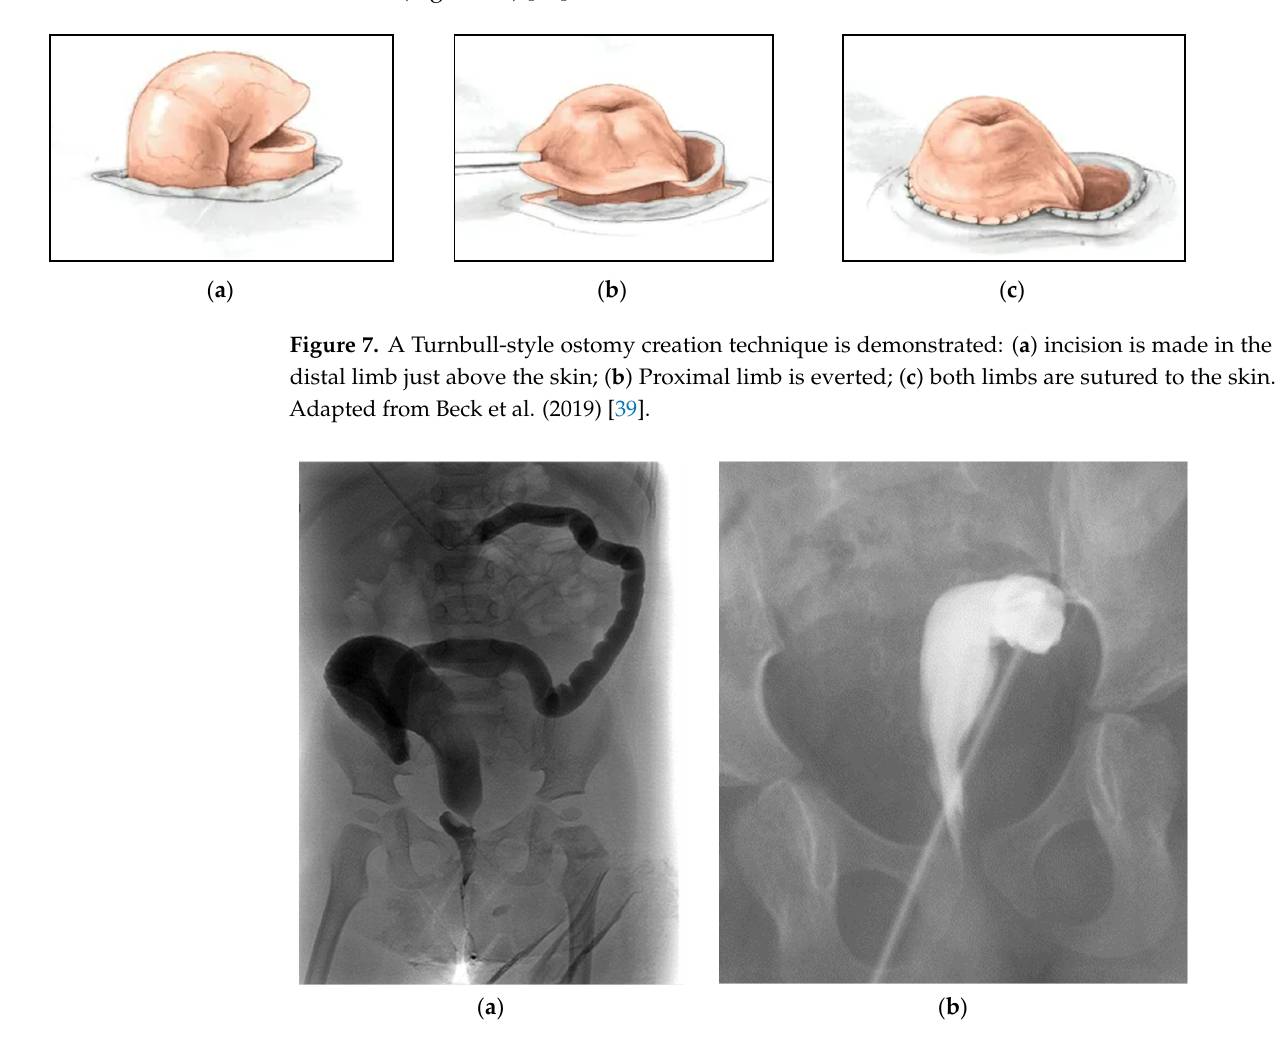
Figure 8. Distal colostogram images showing complications related to stoma and fistula placement, demonstrating ( a ) very long distal bowel from a transverse colostomy, and ( b ) very short segment of distal rectum from a colostomy placed too distally in the sigmoid